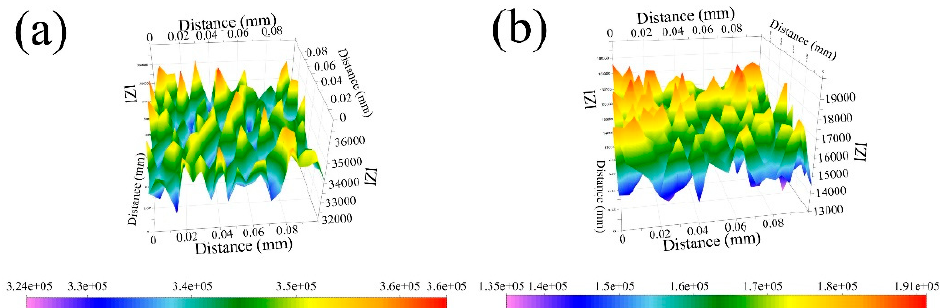
Figure 11. Maps of the impedance module distribution on the surface of the CrFeCoNi ( a ) and CrMnFeCoNi ( b ) coatings in 3.5 wt% NaCl solution.